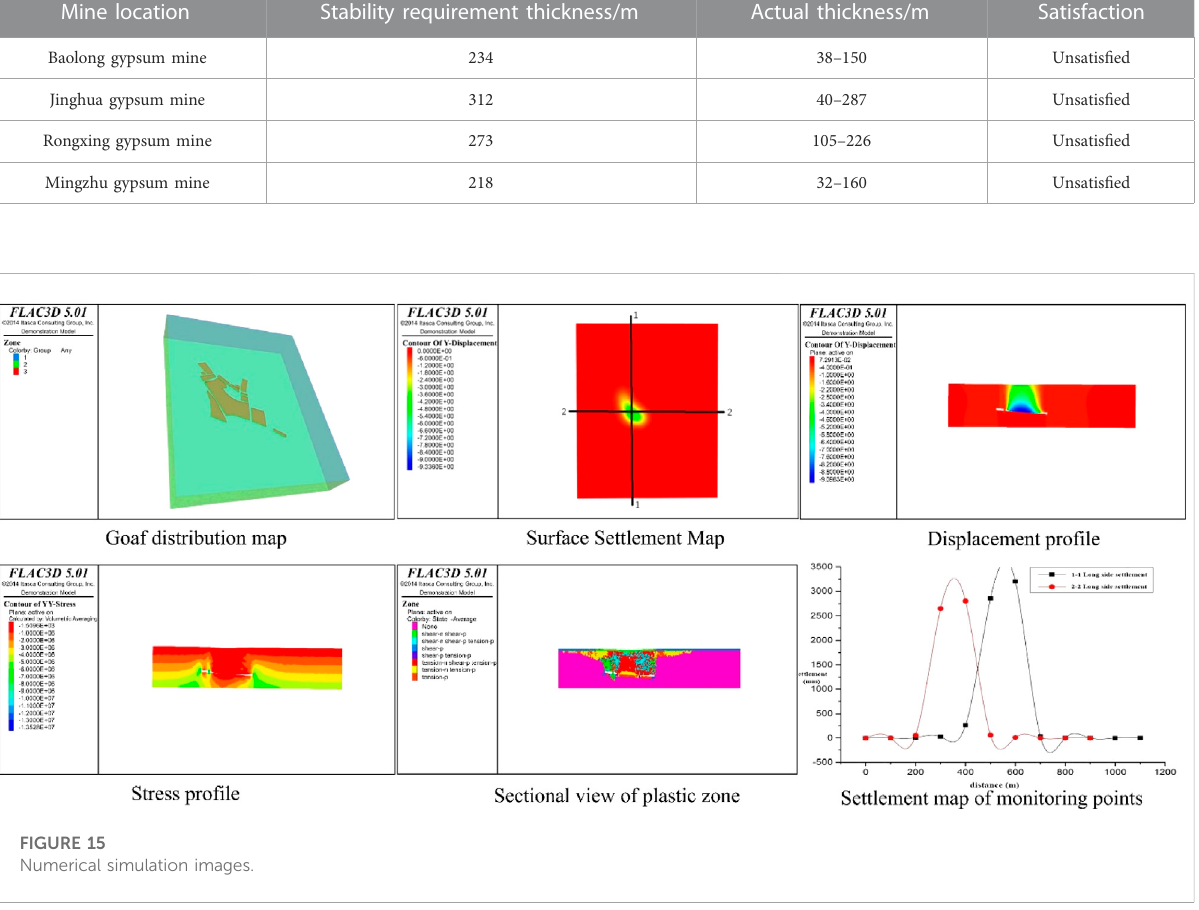
TABLE 9 Overburden thickness calculation table. Mine location